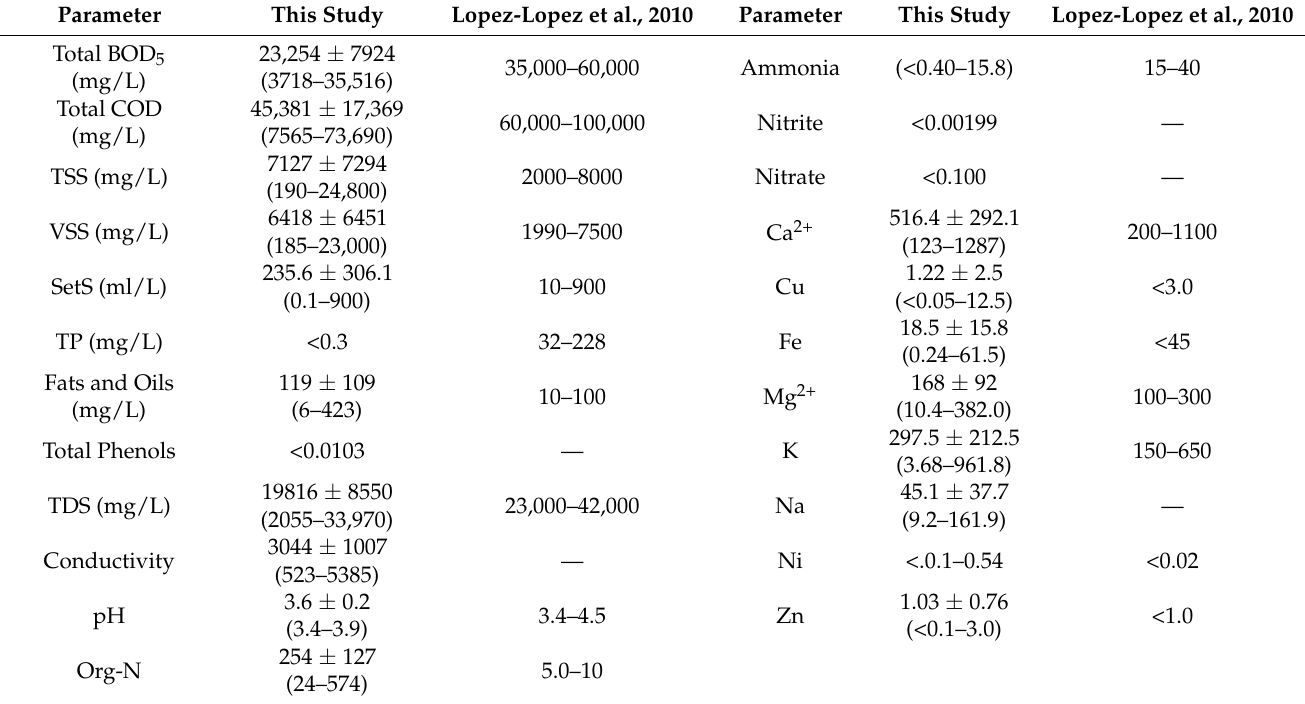
Table 2. Characterization of Tequila vinasse (Average ± Standard Dev. n = 24) and values of the characterization performed by L ó pez-L ó pez et al. (2010).